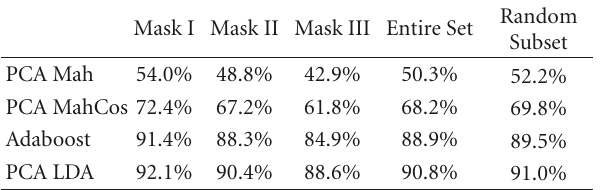
Table 1: The verification rates at FAR = 0.1% of several Face Recognition Methods which allow us to compare the registration methods, these verification rates are achieved using manually registered